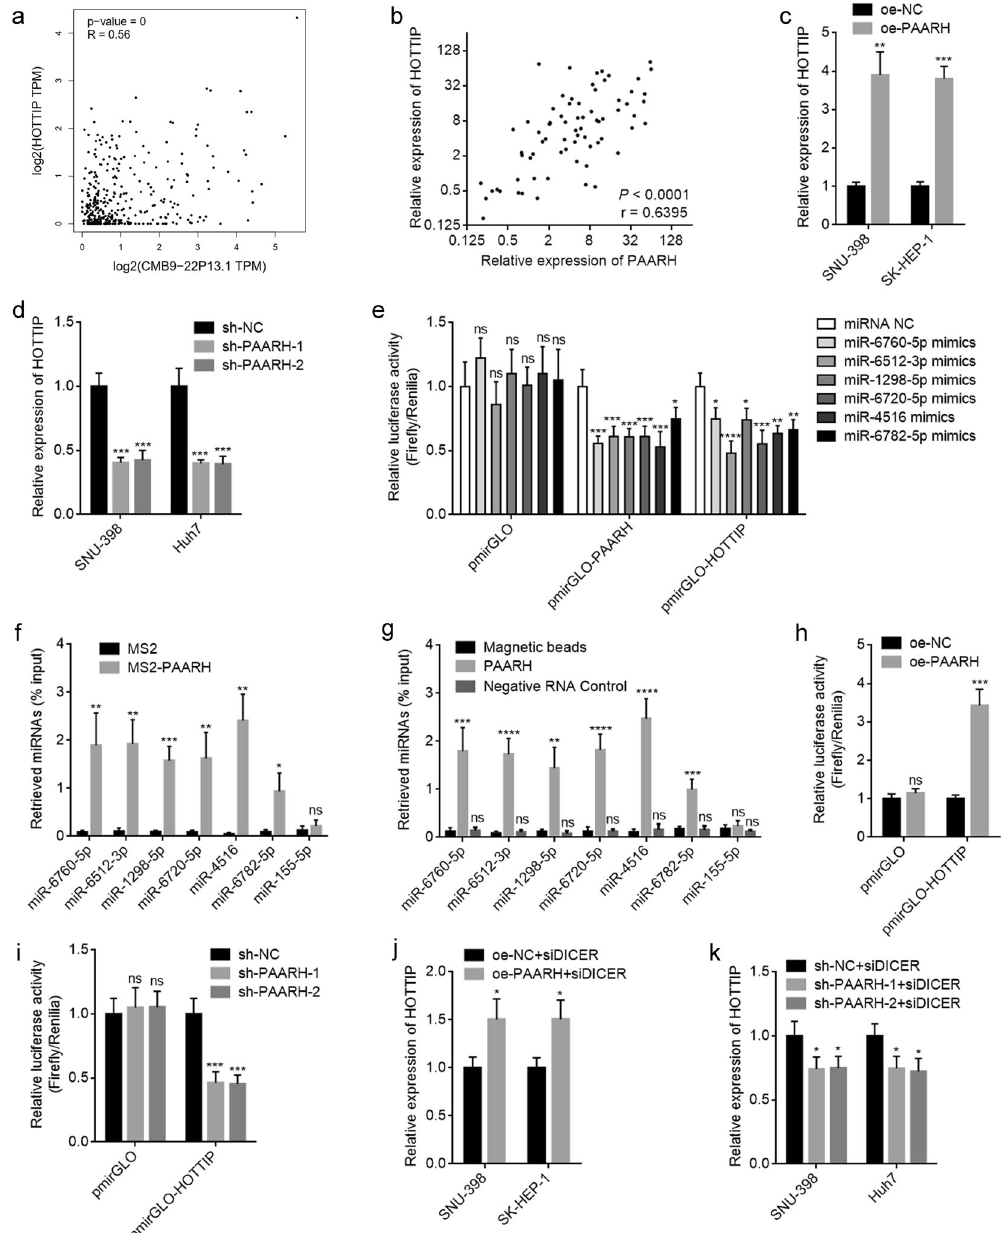
Fig. 5 PAARH increased HOTTIP expression via functioning as a ceRNA. a The correlation between HOTTIP and PAARH (CMB9-22P13.1) expression in HCC tissues according to TCGA LIHC dataset, analyzed by GEPIA. b The correlation between HOTTIP and PAARH expression in our HCC cohort. n = 72, p < 0.0001, r = 0.6395 by Spearman correlation analysis. c HOTTIP expression levels in SNU-398 and SK-HEP-1 cells with PAARH overexpression or control were measured by qRT-PCR. d HOTTIP expression levels in SNU-398 and Huh7 cells with PAARH stable silencing or control was measured by qRT-PCR. e Luciferase activity in SNU-398 cells co-transfected with miR-6760-5p, miR-6512-3p, miR-1298- 5p, miR-6720-5p, miR-4516, or miR-6782-5p and luciferase reporters containing nothing, PAARH or HOTTIP. Results are shown as the relative ratio of fi re fl y luciferase activity to renilla luciferase activity. f MS2 based RIP assays followed by qRT-PCR to detect miRNAs bound to PAARH. g RNA pull-down experiments using RNA end-labeled with desthiobiotin, followed by qRT-PCR to detect miRNAs bound to PAARH. h Luciferase activity in SNU-398 cells with PAARH overexpression or control after transfection of luciferase reporters containing nothing or HOTTIP. Results are shown as the relative ratio of fi re fl y luciferase activity to renilla luciferase activity. i Luciferase activity in SNU-398 cells with PAARH silencing or control after transfection of luciferase reporters containing nothing or HOTTIP. Results are shown as the relative ratio of fi re fl y luciferase activity to renilla luciferase activity. j HOTTIP expression levels in SNU-398 and SK-HEP-1 cells with PAARH overexpression or control after transfection of DICER siRNA pool were measured by qRT-PCR. k HOTTIP expression levels in SNU-398 and Huh7 cells with PAARH stable silencing or control after transfection of DICER siRNA pool was measured by qRT-PCR. For c – k , results are shown as mean ± SD based on three independent experiments. * p < 0.05, ** p < 0.01, *** p < 0.001, **** p < 0.0001, ns not signi fi cant by Student ’ s t test ( c , f , h , j ) or one-way ANOVA followed by Dunnett ’ s multiple comparisons test ( d , e , g , i , k